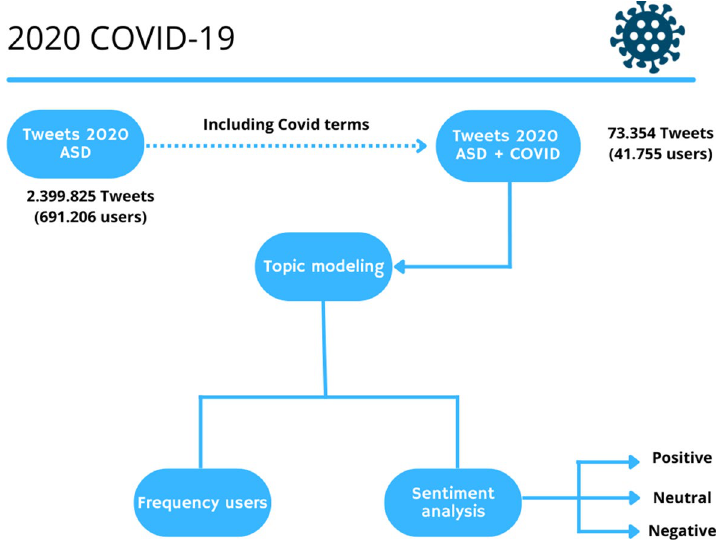
Fig. 4 Data flow overview 2020 COVID-19